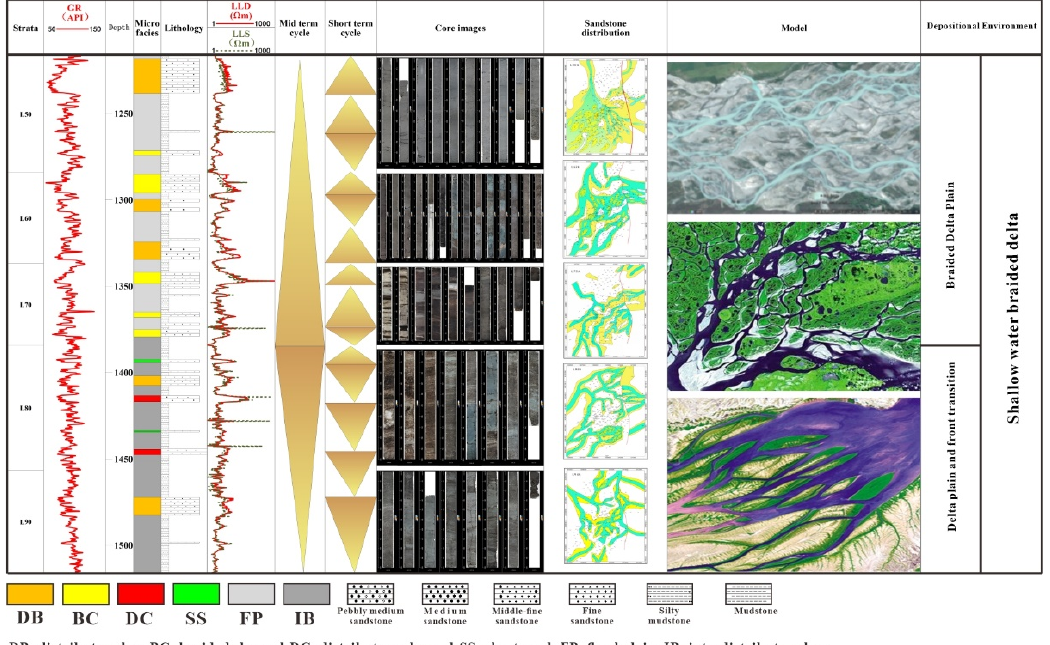
Figure 10. Geologic column of the core section of well PL25 − 6 − A. This vertical geologic column includes logging facies, sedimentary microfacies, sedimentary facies spatial distribution, sedimentary rhythm, lithology information, and a similar modern delta sedimentary map, which can intuitively show the vertical changes in geological features.